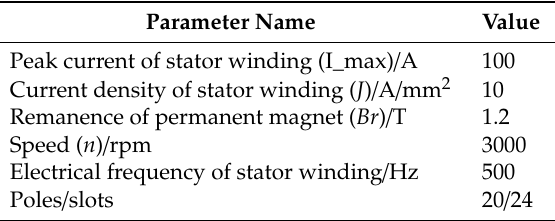
Table 2. Input electromagnetic parameters of the